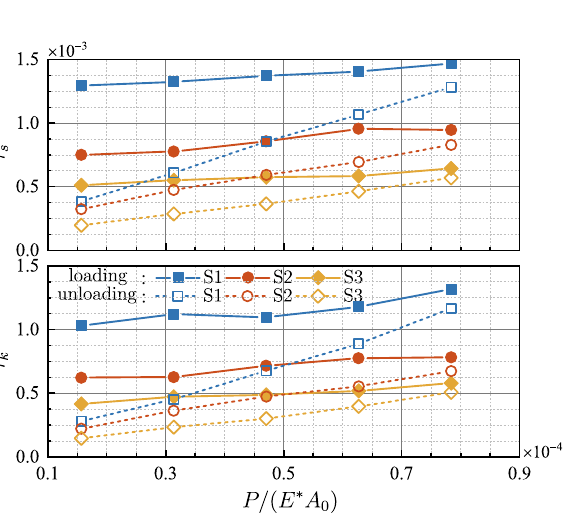
Figure 10. The dimensionless kinetic friction force F k /( E*A 0 ) under various contact fractions A r / A 0 .